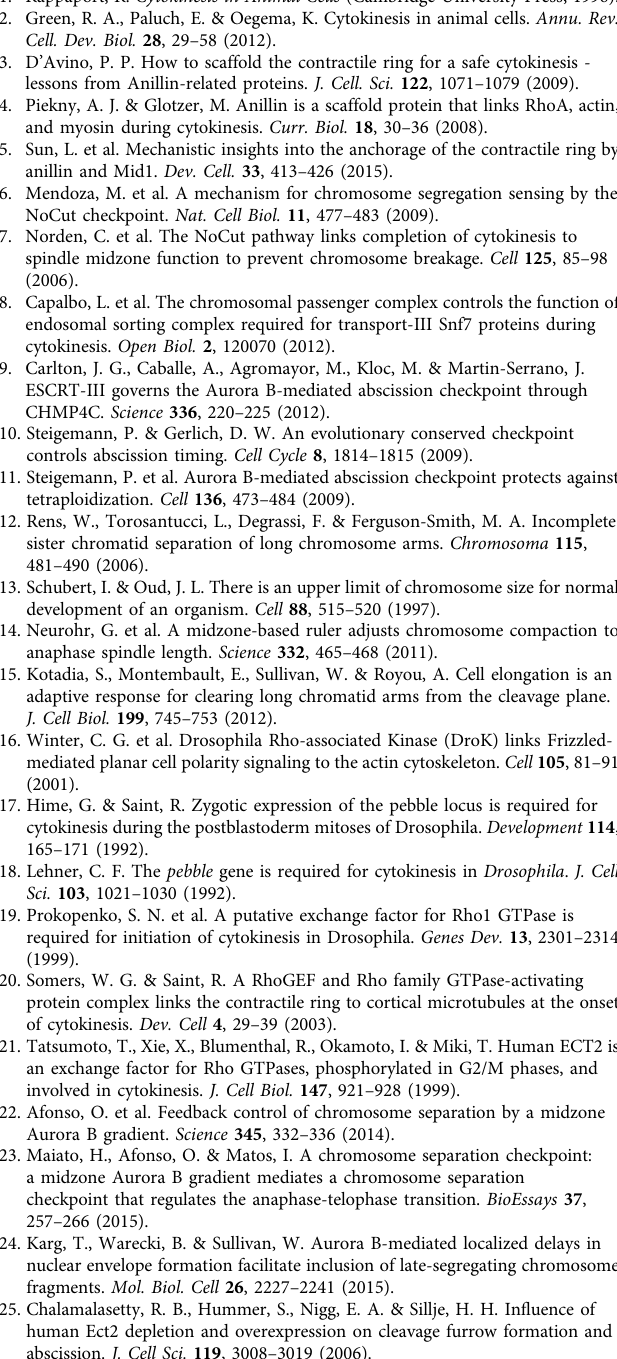
Fig. 5f, the GFP::NLS average intensity signal was quanti fi ed on a region of interest drawn at the presumptive nuclear position. We subtracted the average intensity of cytoplasmic GFP::NLS from this value. The data were normalized with the average intensity of GFP::NLS signal in the cytoplasm. For Figs. 1h and 5f, the data points were fi t to a sigmoid curve ( Y = 1/(1 +10 ((LogEC-X)*HillSlope) ) using Prism (GraphPad) to determine the hillslope (h). All statistical analyses were